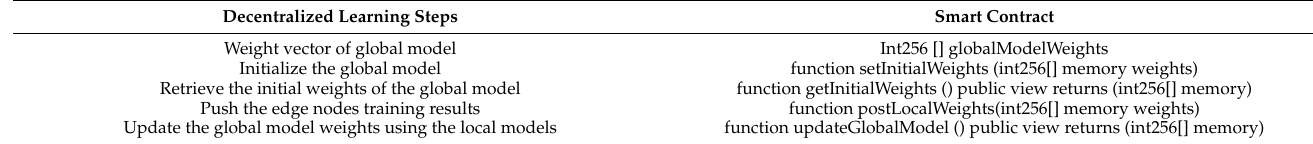
Table 2. FL concepts mapped to smart